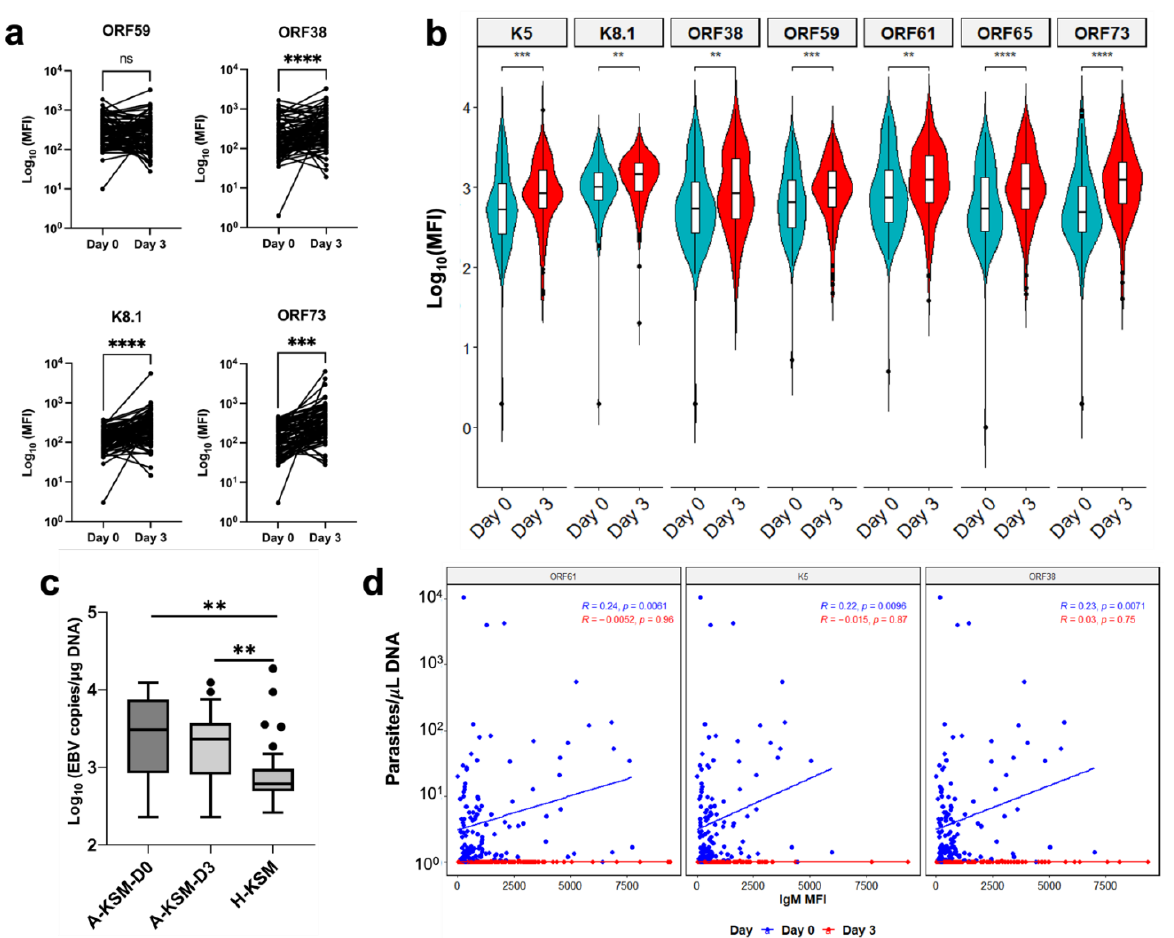
Figure 3. Variation in paired KSHV antibody responses during acute malaria episodes. ( a ) Paired comparisons of log-scale IgG antibodies against early (ORF59), late lytic (ORF38 and K8.1), and latency-associated antigen, ORF73 in KSHV-seropositive A-KSM children at Day 0 and 3 of malaria infection (Wilcoxon matched-pairs signed rank test; *** p < 0.001; **** p < 0.0001, ns: p > 0.05). ( b ) Paired comparison of log-scale IgM antibodies against 7 KSHV antigens at Days 0 and 3 of acute malaria infection (Wilcoxon matched pairs signed rank test with BH correction for multiple comparisons; ** p < 0.01; *** p < 0.001; **** p < 0.0001). ( c ) Comparison of EBV load in acute malaria-infected and healthy children from Kisumu (Wilcoxon rank-sum test, ** p < 0.01) Boxplots include the sample medians, minimum/maximum values, and first/third quartiles. ( d ) Spearman Correlation (r) test of parasite density and IgM antibodies against KSHV ORF61, K5 and ORF38 antigens. Abbreviations: KSHV, Kaposi sarcoma-associated herpesvirus; EBV, Epstein – Barr virus